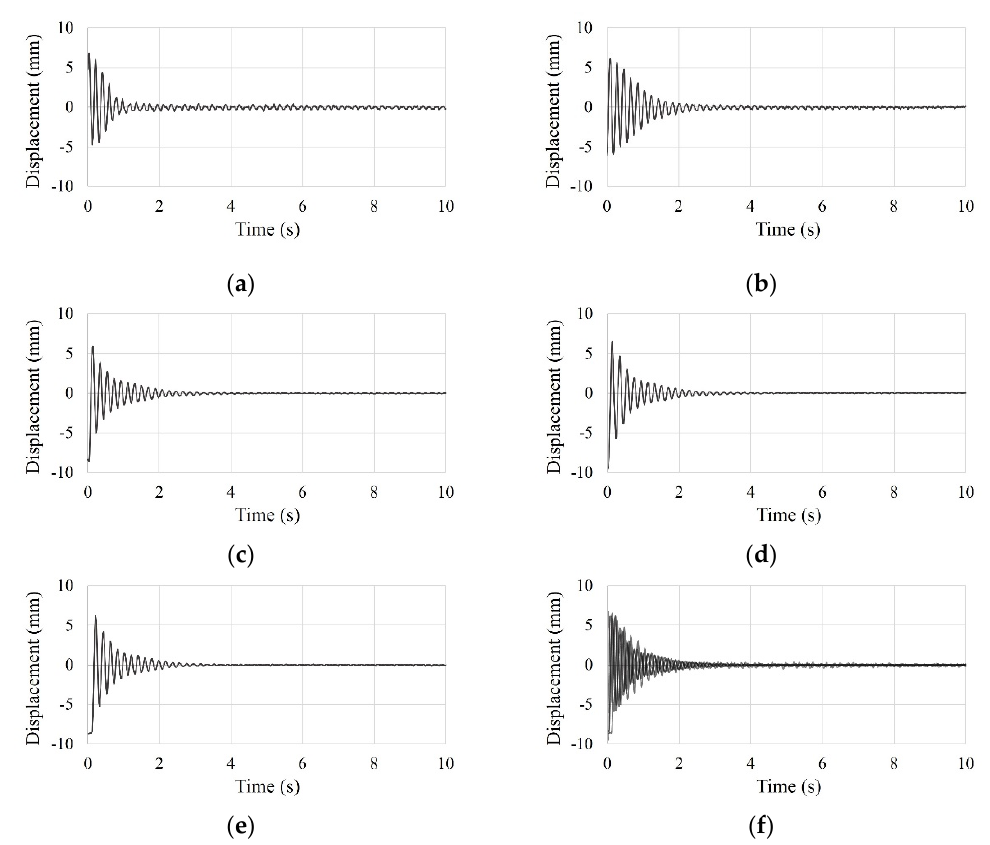
Figure 8. Time history curve of the small-scale model by free vibration test: ( a ) first test; ( b ) second test; ( c ) third test; ( d ) fourth test; ( e ) five test; ( f ) overlapping entire tests. The damping ratio can be obtained from the time history curve of the free vibration test using the logarithmic decrement method [33,35]. The logarithmic decrement method is to calculate the damping ratio ( ξ ) with reduction peak amplitude ( u ) for j cycles (Figure 9) under free vibration as follows: